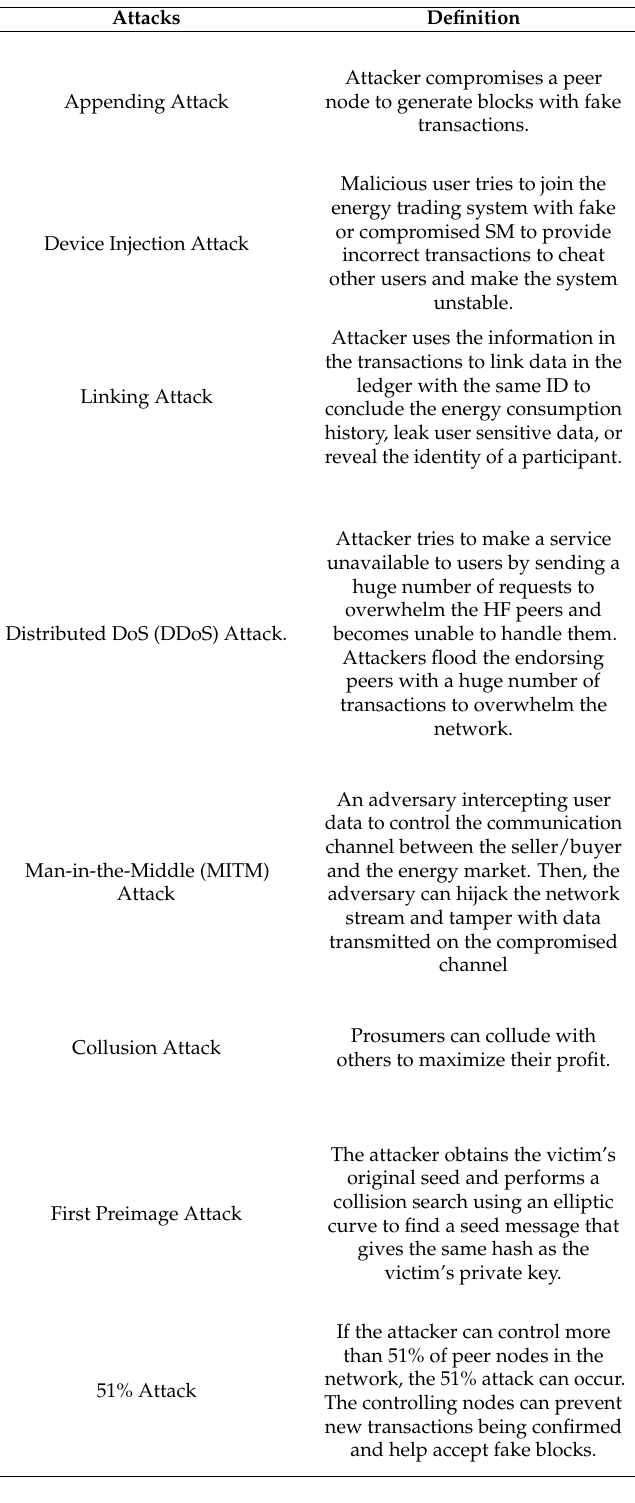
Table 2. Possible attacks on blockchain and energy trading